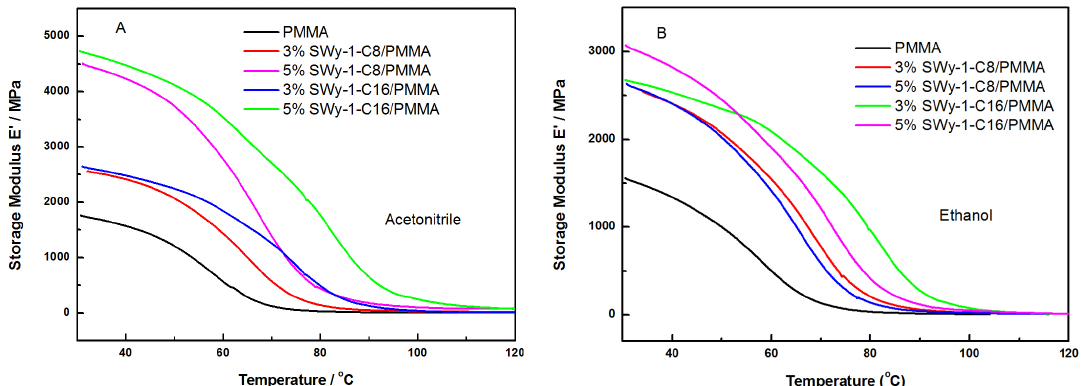
Figure 2. Temperature dependence of storage modulus (E’) of PMMA and nanocomposites synthesized in acetonitrile (a) and synthesized in ethanol